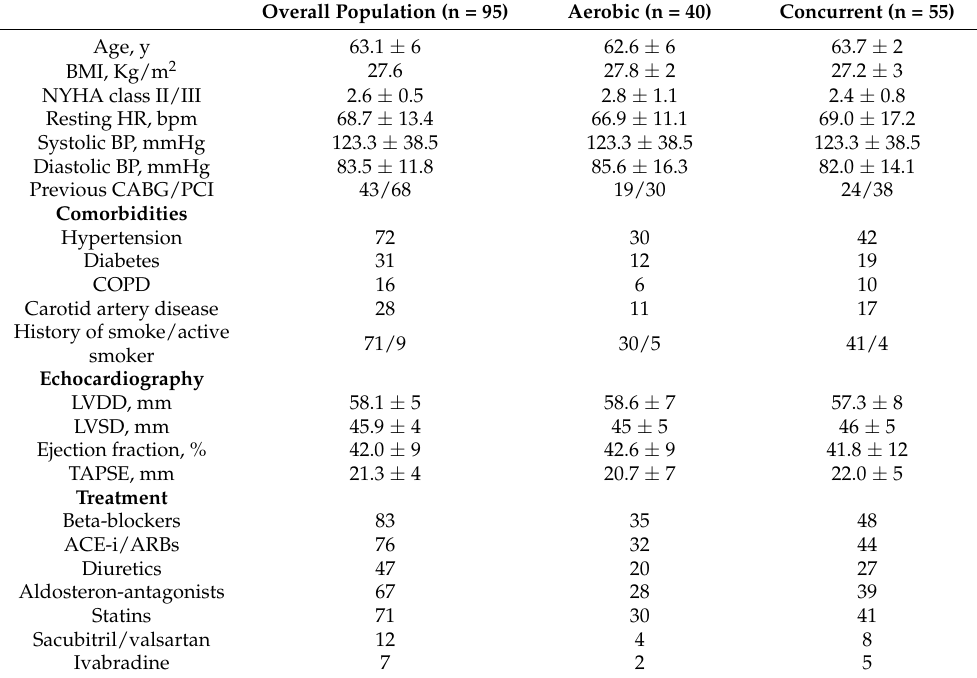
Table 1. Baseline characteristics of patients.